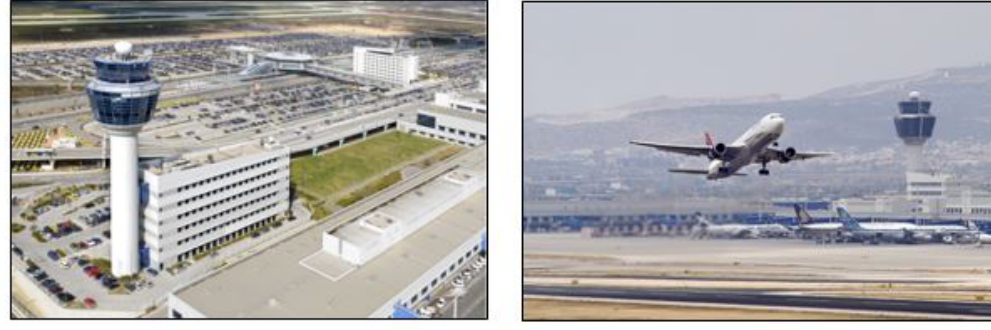
Figure 1: The Airport Table 1: Airport